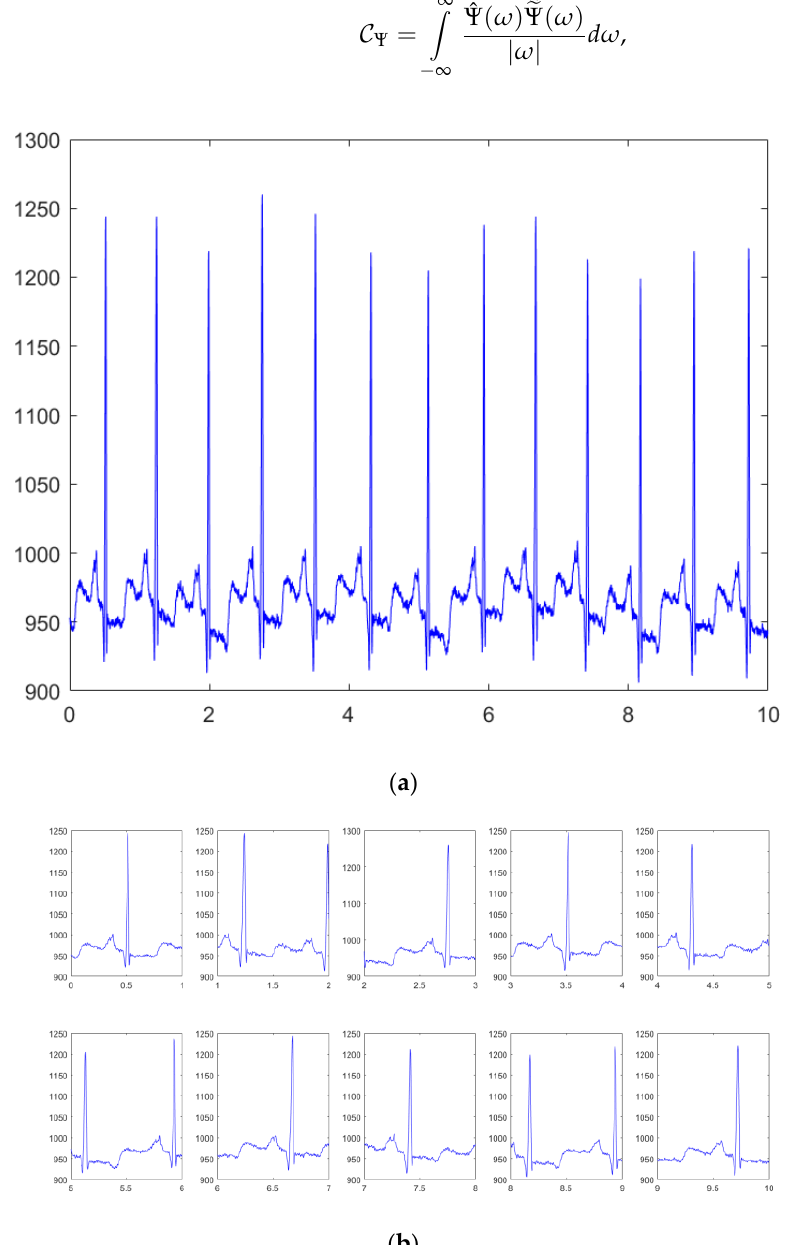
Figure 3. Complete ECG signal with its segmented beats: ( a ) complete ECG signal; ( b ) segmented beats.